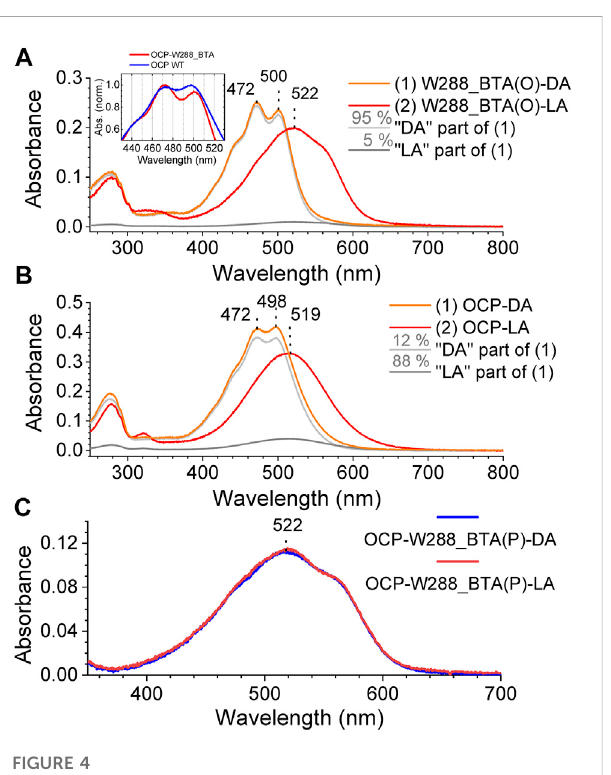
(Figure 4A, inset). These features of the OCP-W288_BTA(O) protein, a spectrally more homogenous dark-adapted state and a deeper vibrational substructure are typical attributes of so-called “ super-orange ” OCP species, as fi rst described for the OCP-Y201W mutant (Yaroshevich et al., 2021).